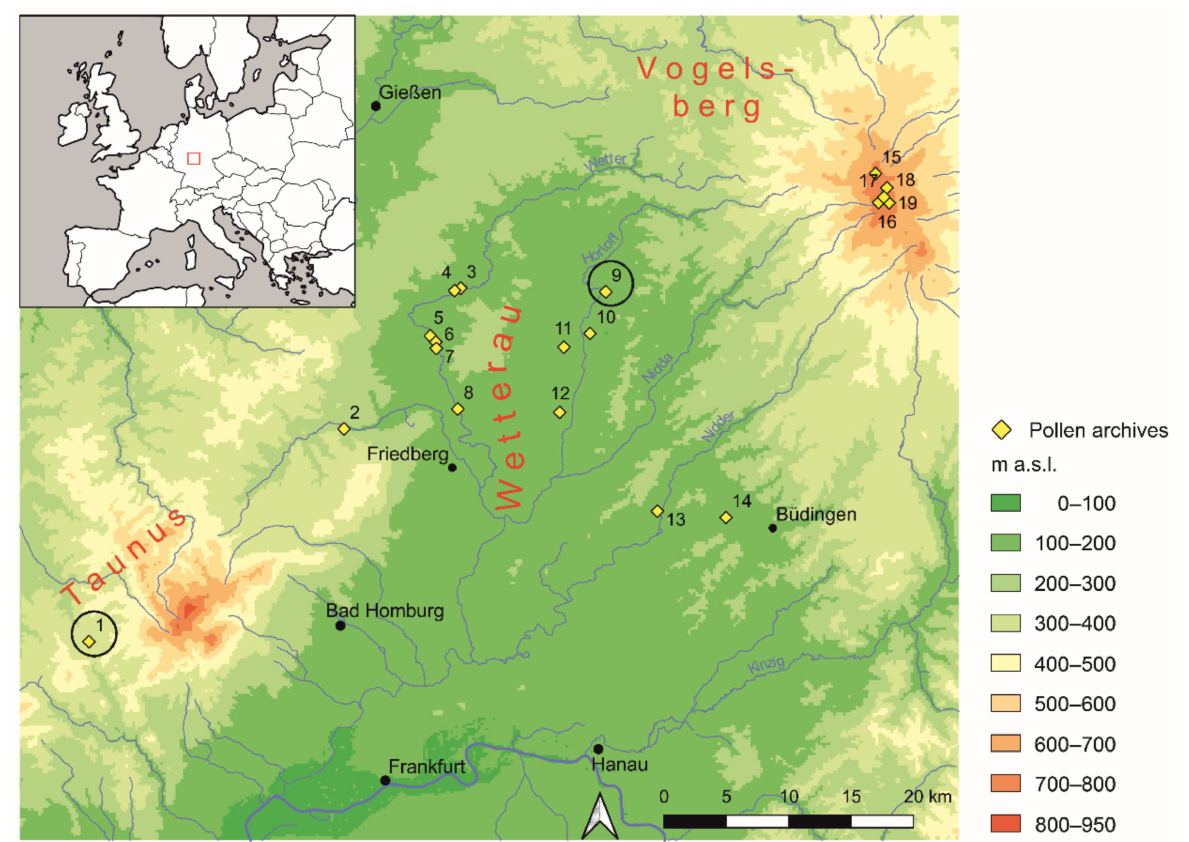
Figure 1. Map of the study region with previously published pollen archives: 1: Heftrich, 2: Usa valley, 3: Salzwiese, 4: Ober- Hörgern 2, 5: Rockenberg, 6: Oppershofen 5, 7: Opershofen 3, 8: Wisselsheim, 9: Moenchborn, 10: Widdersheim/Horloffaue, 11: Dorfwiese, 12: Echzell, 13: Heegheim, 14: Büches, 15: Sieben Ahorn, 16: Forellenteiche, 17: Breungeshainer Heide, 18: Goldwiese, 19: Lattenbruch). Black circles mark the two sites in the focus of this